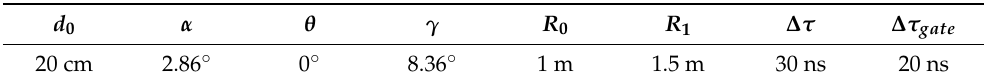
Figure 5. Experiment setup. (1) Laser system, (2) collimation system, (3) telescope, (4) time-delay system, (5) CCD and (6) image intensifier. Table 1. Experimental parameters used in this experiment to ensure F =